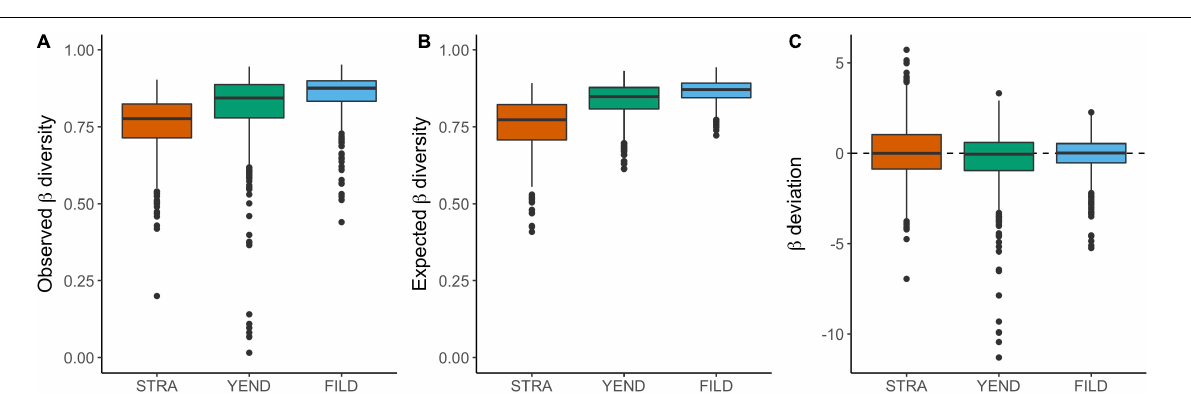
FIGURE 4 | Incidence-based beta diversity (Jaccard’s dissimilarity): Observed (A) and null expected (B) beta diversity across the three localities. Beta deviation (C) is beta diversity after controlling for differences in gamma diversity. Similar results were obtained when using abundance-based beta diversity (Bray-Curtis, Supplementary Figure 1